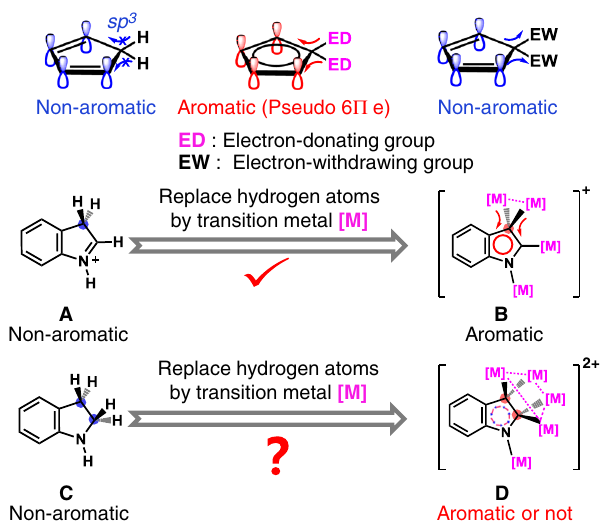
Fig. 1 Hyperconjugative aromaticity (HA) comparison in indolium derivatives. Electron-donating groups strengthen the aromaticity in cyclopentadiene while electron-withdrawing groups act in an opposite way. Transition metal substituents in polymetalated compounds B and D give better performance on HA over the hydrogen atoms in organic models A and C